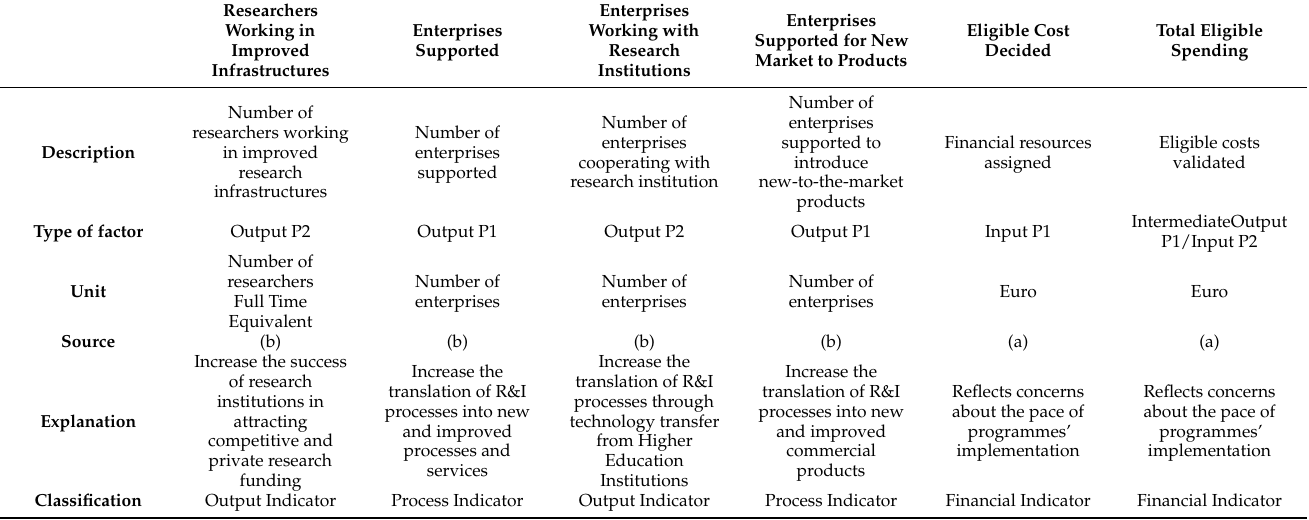
Table 3. Inputs and Outputs